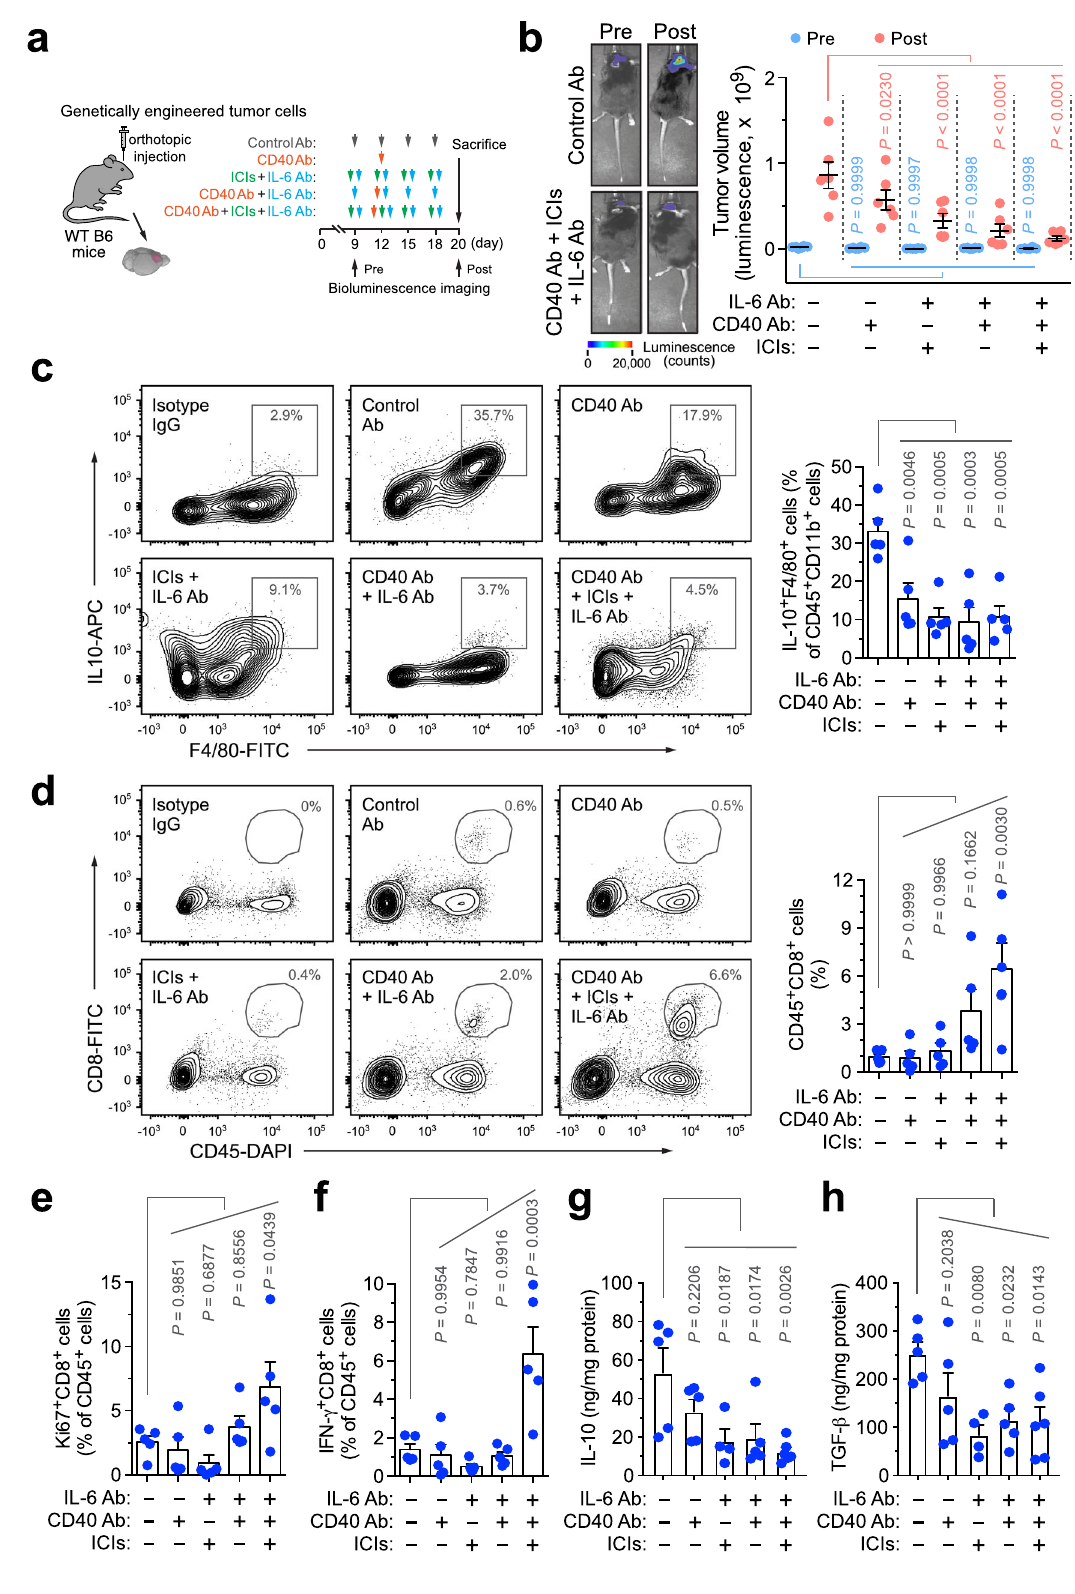
Mice . WT mice on the C57BL/6J background were obtained from Jackson Lab. Cdh5-Cre ERT2 ; Il6 fl / fl mice were generated by crossing Il6 fl / fl mice with Cdh5- Cre ERT2 mice 67 . Mice (2 weeks old) were intraperitoneally injected with 0.1ml of 5 mg/ml tamoxifen daily for consecutive 5 days. All animals were housed at room temperature with a 12h-light/12h-dark cycle in the Association for the